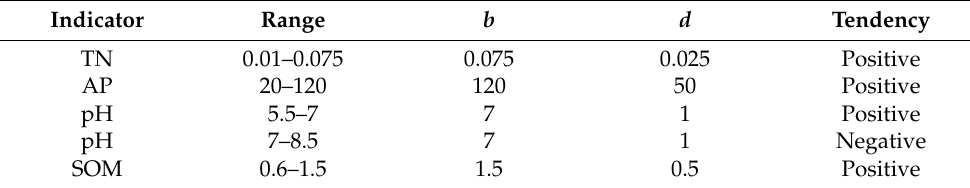
Table 4. The parameters of the fuzzy logic